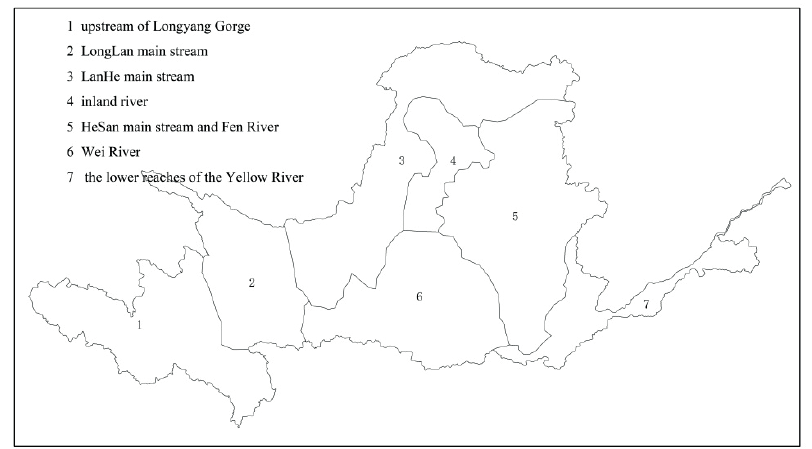
Fig. 2 The sub-regions of the Yellow River basin.